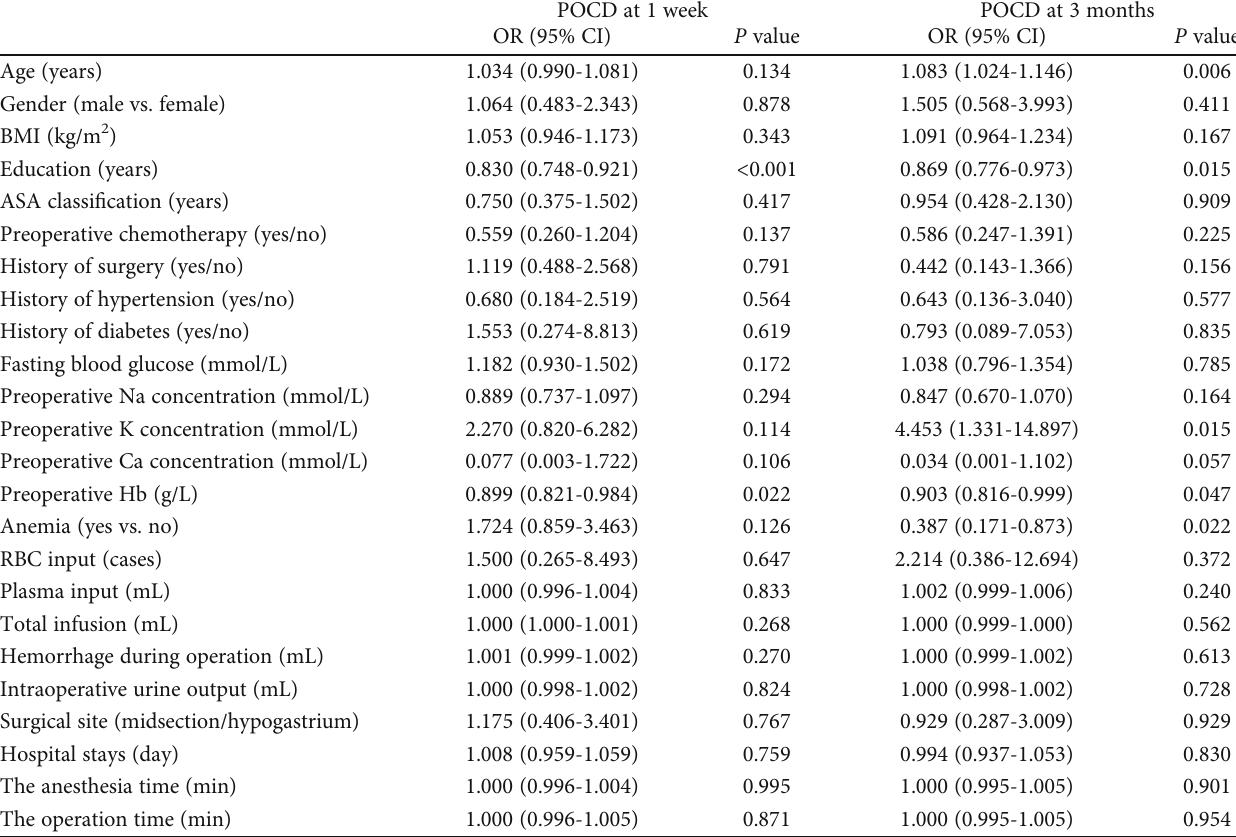
Table 3: Univariate analysis results for POCD at 1 week and 3 months after operation.